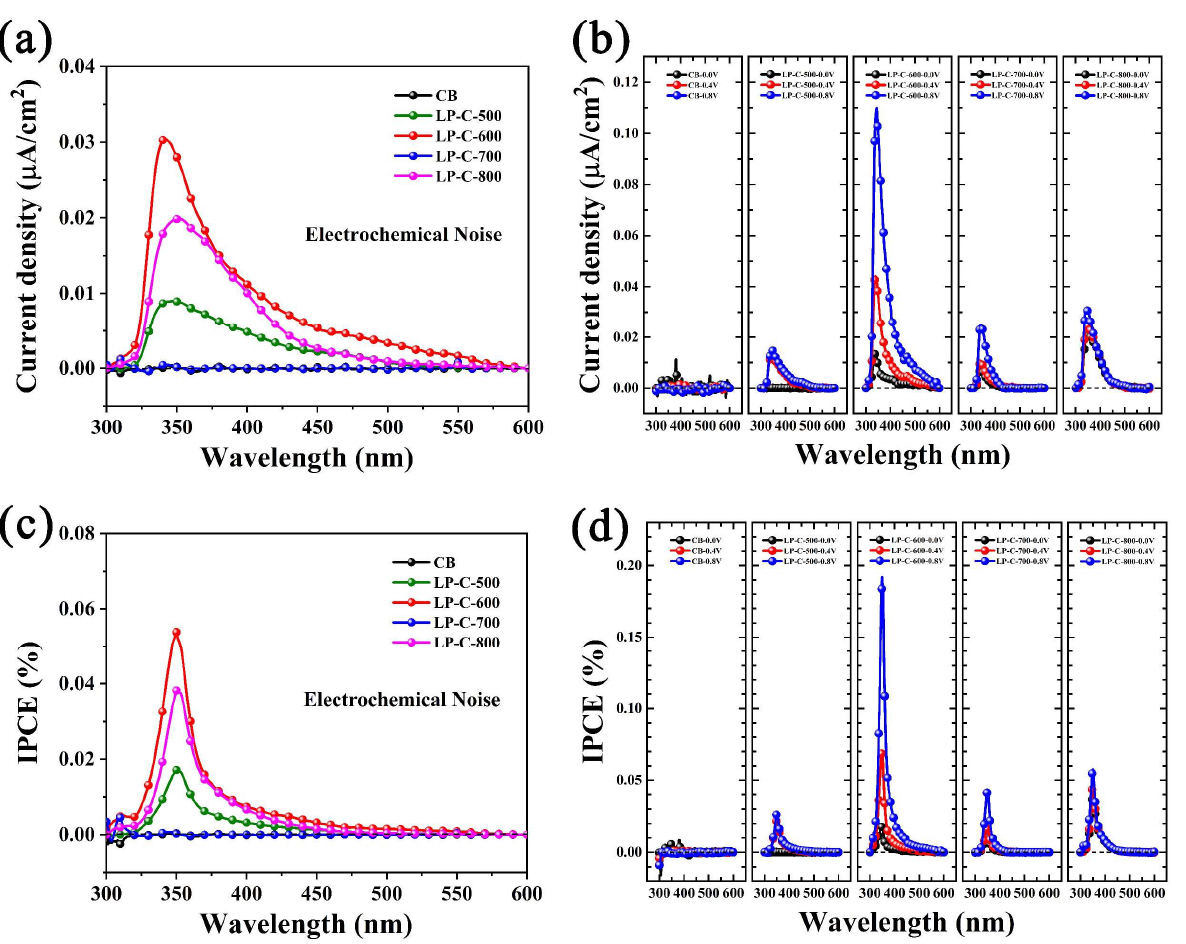
Figure 8. Photocurrents density of samples versus the wavelength of incident light at ( a ) electrochemical noise mode and ( c ) with 0 V, 0.4 V, and 0.8 V applied voltages (vs. Ag/AgCl); ( b , d ) the derived IPCE (%) spectra.